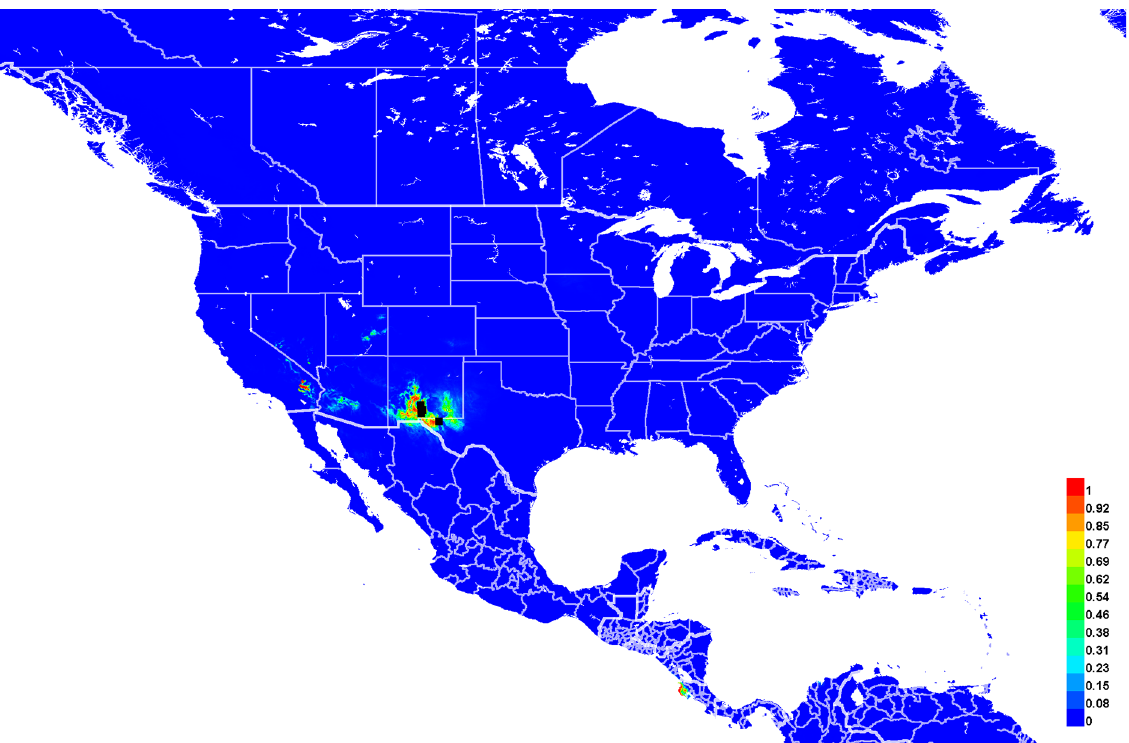
Fig. 12. Georeferenced collection records of Lasioglossum ( D. ) argammon sp. nov. (black squares) and predicted distribution by maximum entropy ecological niche modeling in Maxent (colour shading). Warmer colours indicate higher cloglog probability of occurrence. Due to the very small number of records, this distribution should be interpreted with